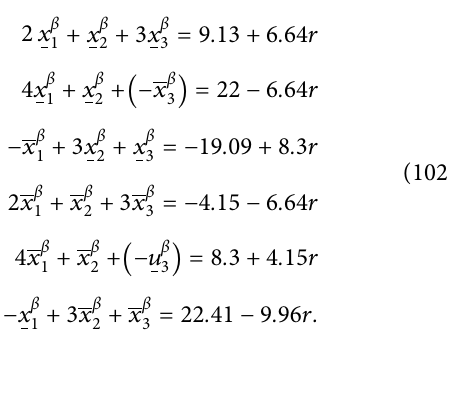
Figure 9: Te confdence chart of 􏽥 U